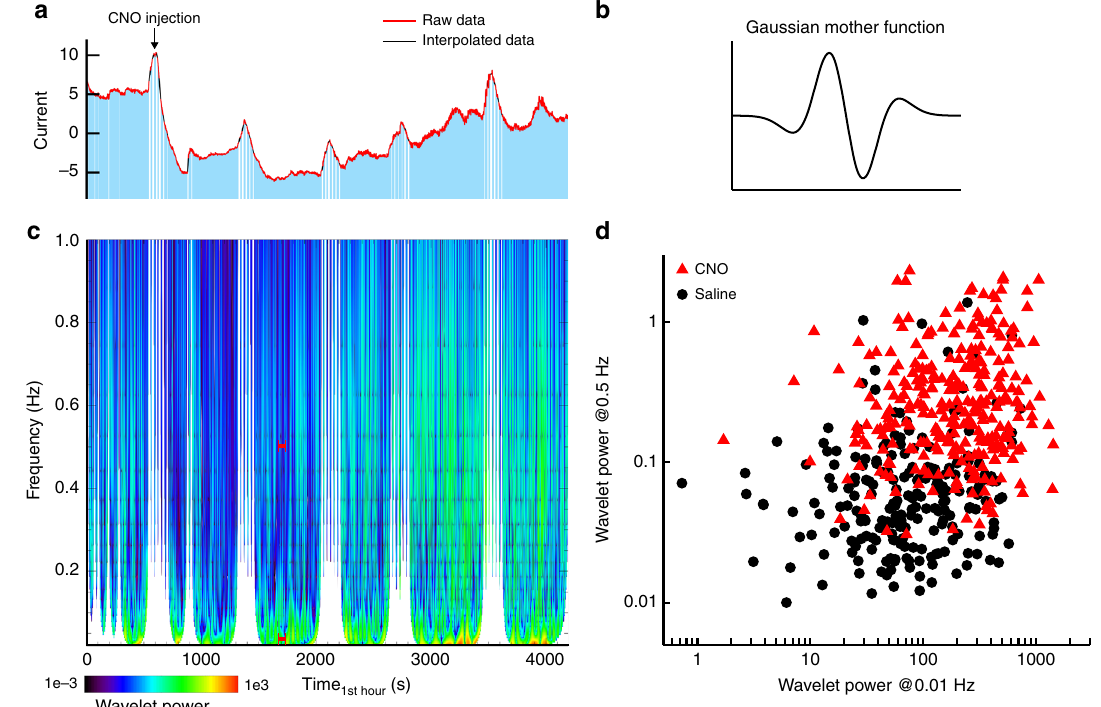
Fig. 5 Wavelet power of continuous FSCV recordings. a Continuous FSCV data recorded in the ventral striatum of a single mouse. CNO was injected intraperitoneally at t = 600s. b Gaussian mother function that was applied for the wavelet transform. c Contour plot of wavelet power calculated from the FSCV data shown in ( a ). Data gaps were excluded from the analysis together with the corresponding cone of in fl uence (t±2*1/f). The red bars indicate a one-minute interval of low (0.01 Hz) and high frequency (0.5 Hz) power. d Power in the high and low-frequency band after CNO administration (red triangles = hM3D Gq DAT + CNO, n CNO = 4; black circles = hM3D Gq DAT + Saline, n Saline = 3). Each data point represents a one-minute